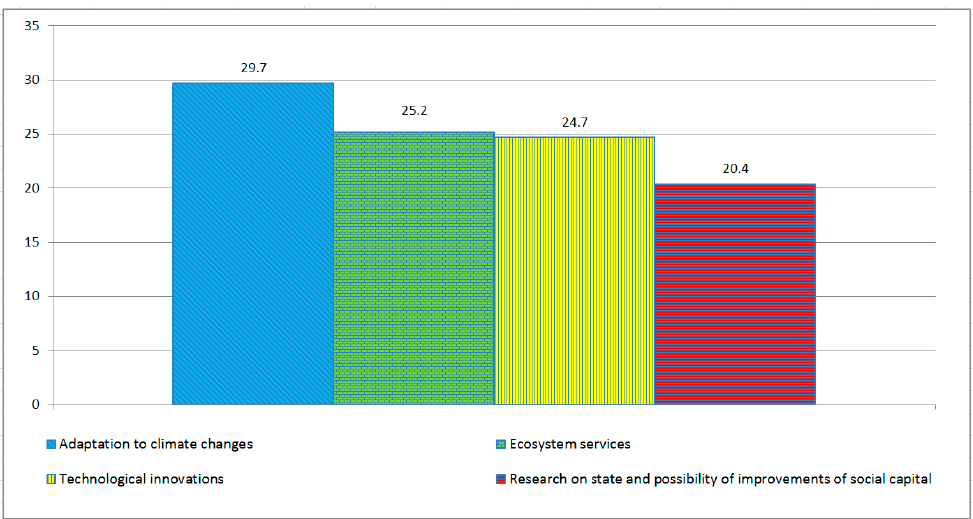
Figure 3. Aggregated results of expert opinions on research areas hierarchy based on CV. Source: Study results.